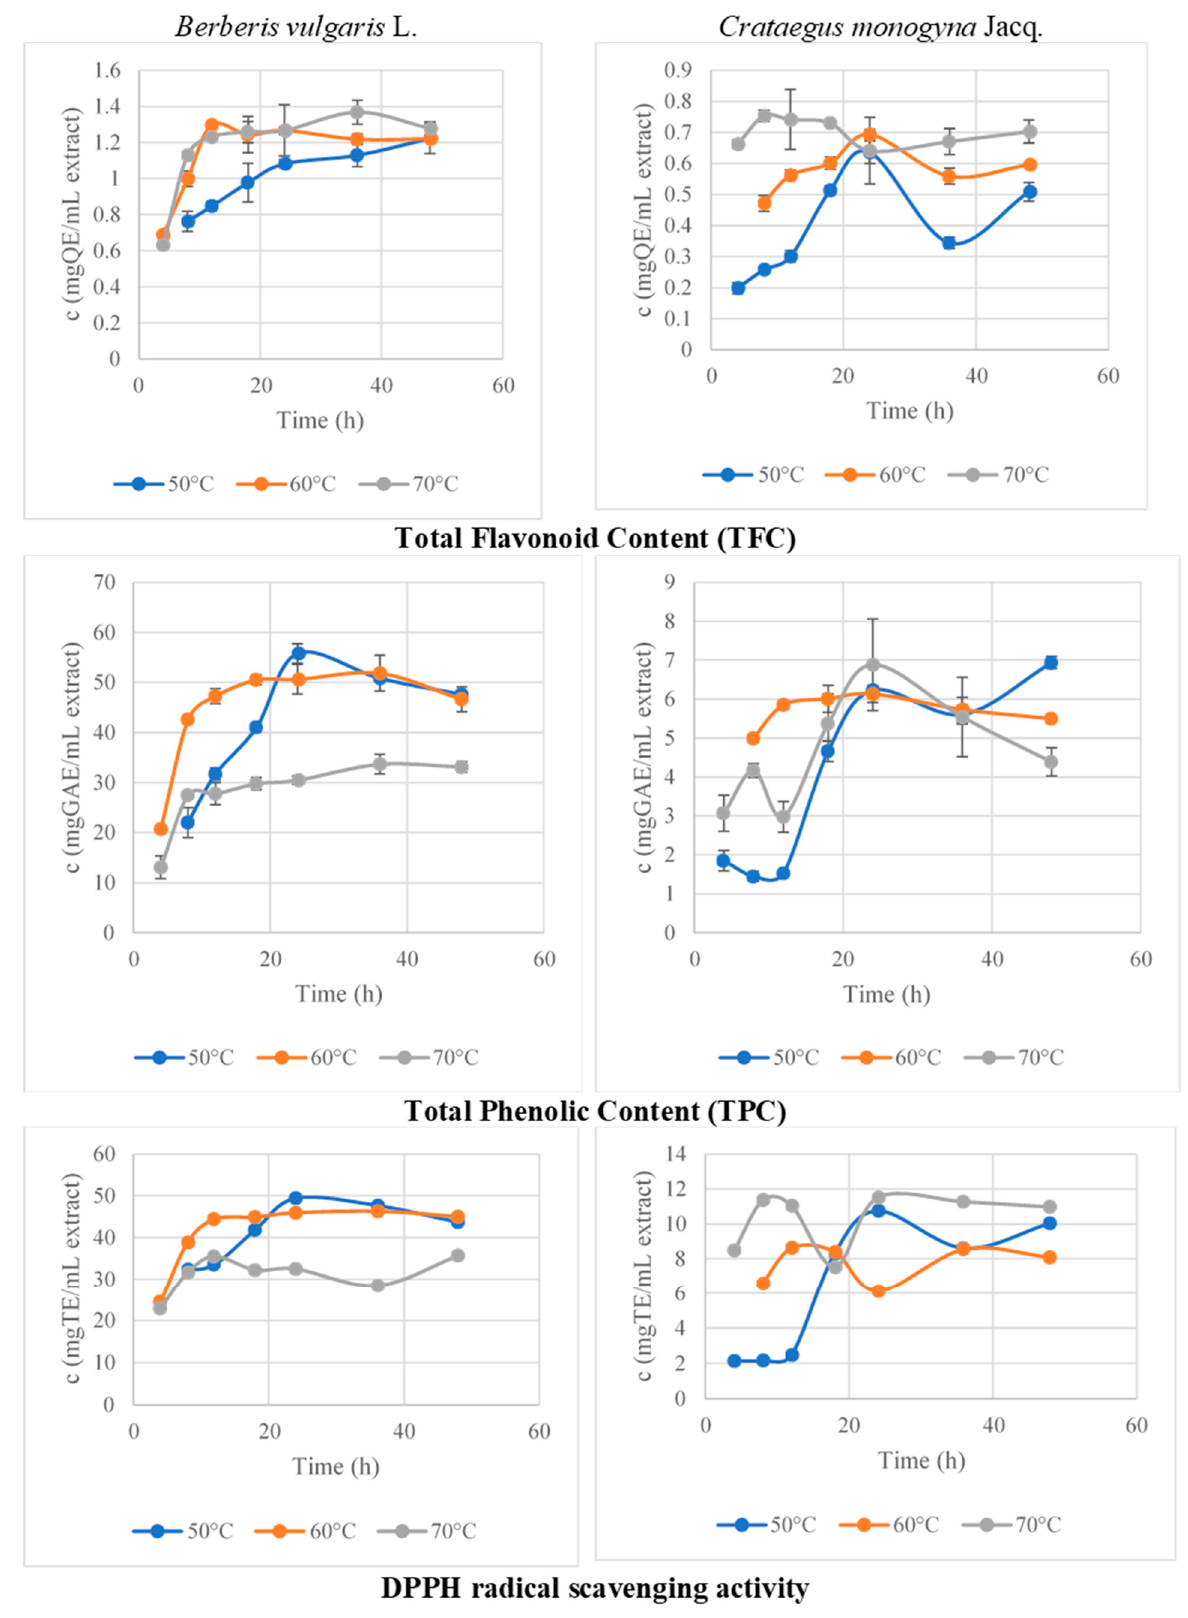
Figure 3. Total phenolic content (TPC), total flavonoid content (TFC), and DPPH radical scavenging activity as a function of time regarding the temperature conditions of drying plant samples (50, 60, and 70 °C).